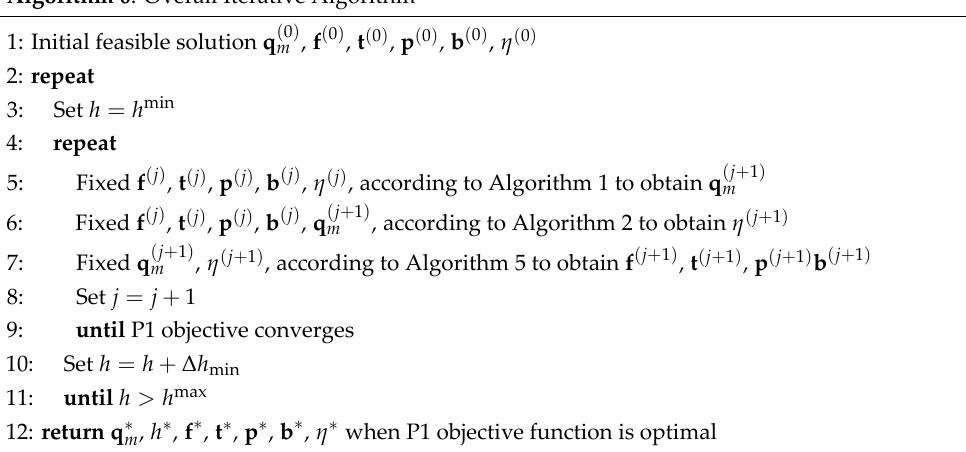
Algorithm 6 : Overall Iterative Algorithm